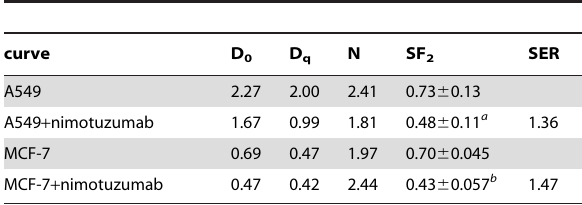
Table 1. Radiobiological parameters of dose-survival curves (shown in Figure 1).